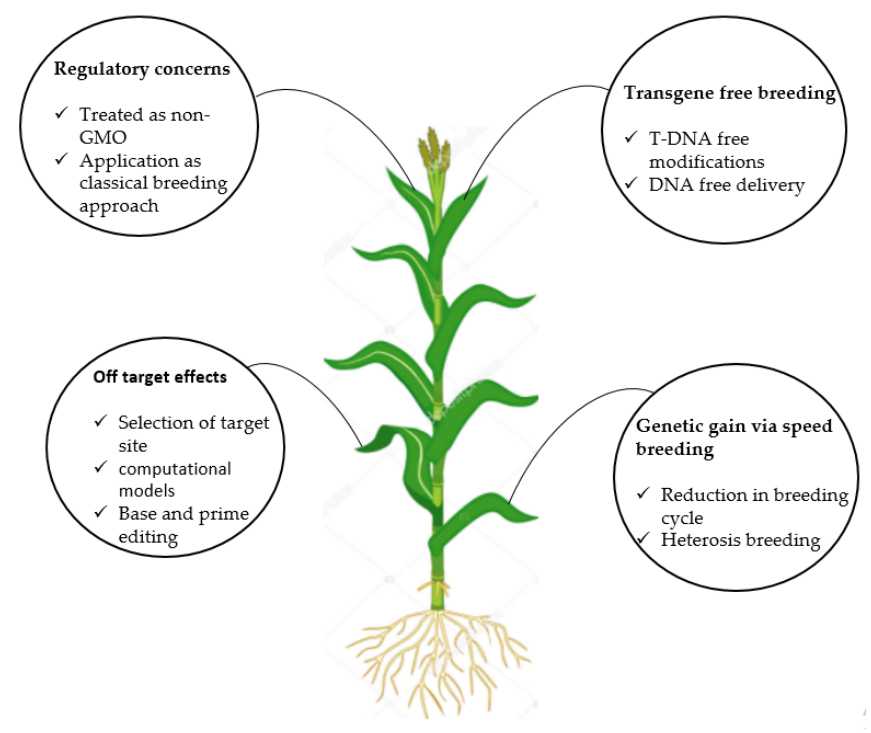
Figure 4. Future perspectives of novel plant breeding techniques for genetic modification in plants genome.